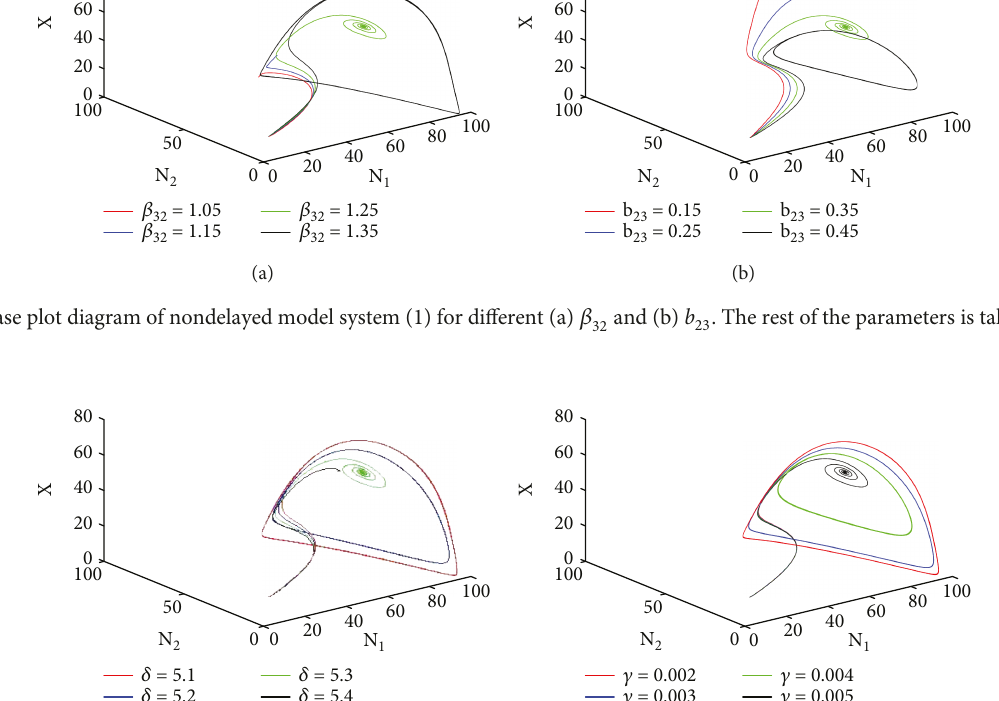
Figure 6: Phase plot diagram of nondelayed model system (1) for di ff erent (a) β and (c) β 31 and (d) b 13 . The rest of the parameters is taken as given in the text.